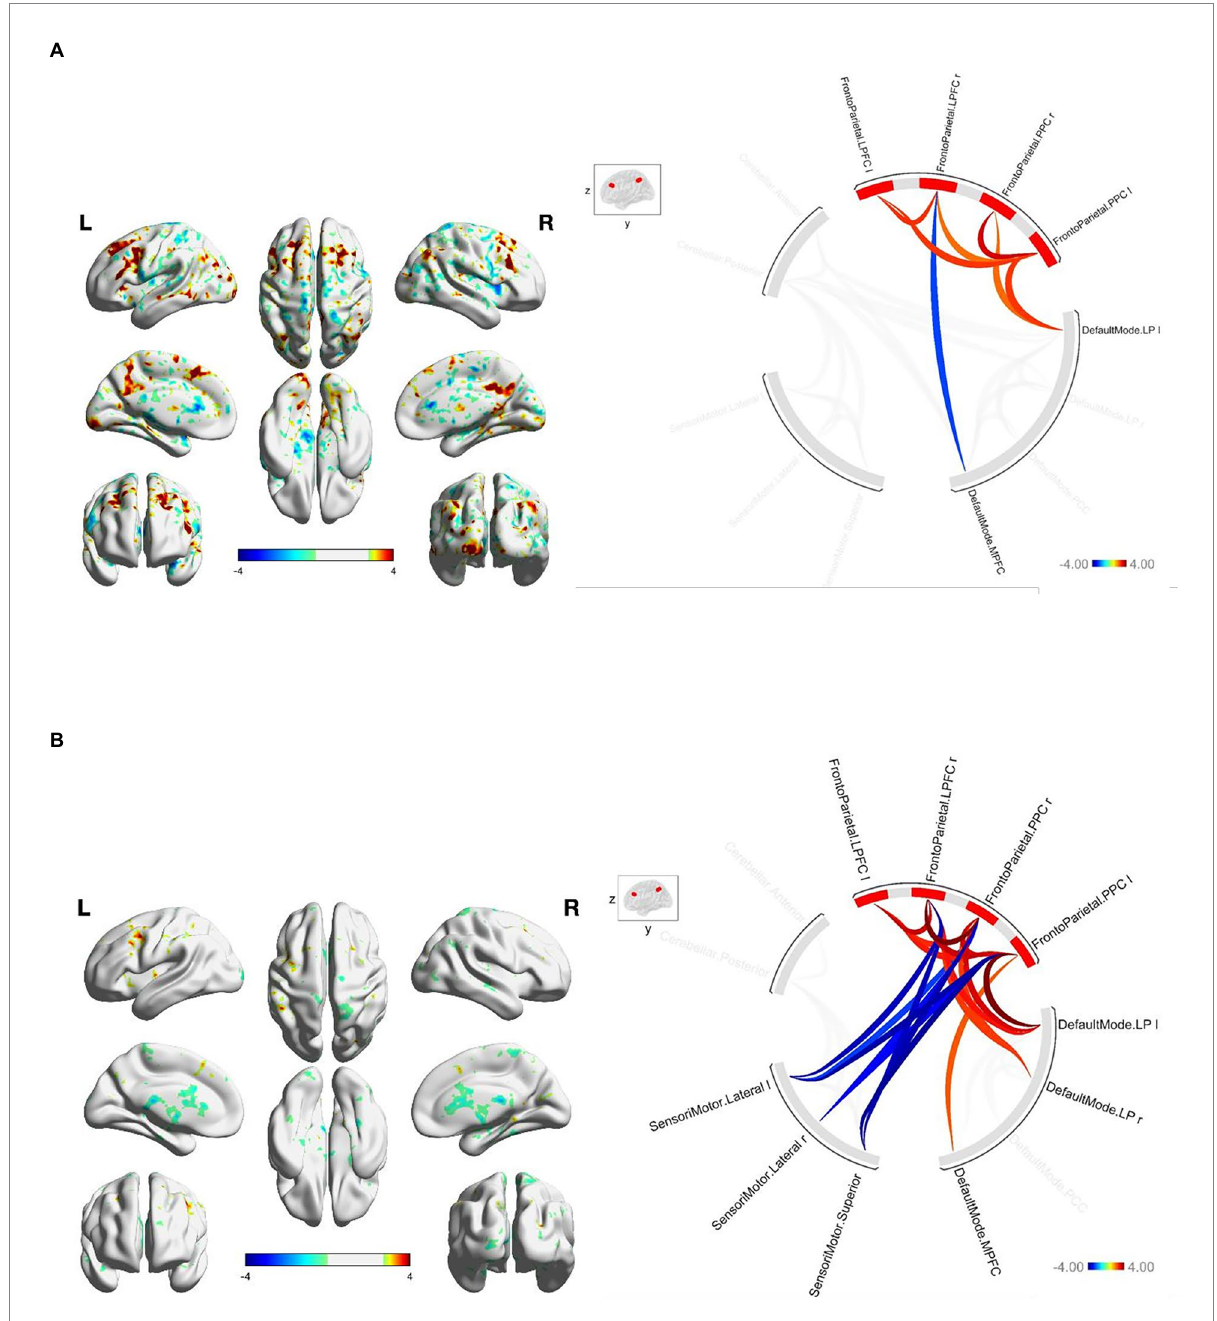
FIGURE3 (A) FGA-related FPN connectivity at baseline. For connectome ring: bottom right quadrant contains nodes of the DMN, top right quadrant contains nodes of the FPN, the top left and bottom left quadrants contain nodes of the cerebellum and SMN. At baseline greater FGA score associated with: greater within-network connectivity within the FPN (uncorrected p < 0.01); greater connectivity between the DMN and FPN (uncorrected p < 0.01). (B) FGA-related FPN connectivity over 26-weeks (26 week – baseline). For connectome ring: bottom right quadrant contains nodes of the DMN, top right quadrant contains nodes of the FPN, the top left and bottom left quadrants contain nodes of the cerebellum and SMN. At 26-weeks greater FGA score was correlated with: greater within-network connectivity within the SMN and FPN (uncorrected p < 0.01); greater connectivity between the DMN and FPN (uncorrected p < 0.01); Statistical brain maps were generated via general linear model (Z > 2.7, p < 0.05 FWE